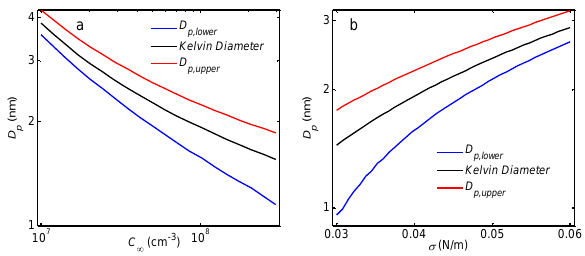
Fig. 3. Variation of D p,lower , D p,upper , and the Kelvin diameter over Figure 3. Variation of D p,lower , D p,upper , and the Kelvin diameter over representative ranges of C  2 representative ranges of C ∞ (a) and σ (b) . All other parameters (a) and  (b). All other parameters remain the same as listed in Table 1. 3 remain the same as listed in Table